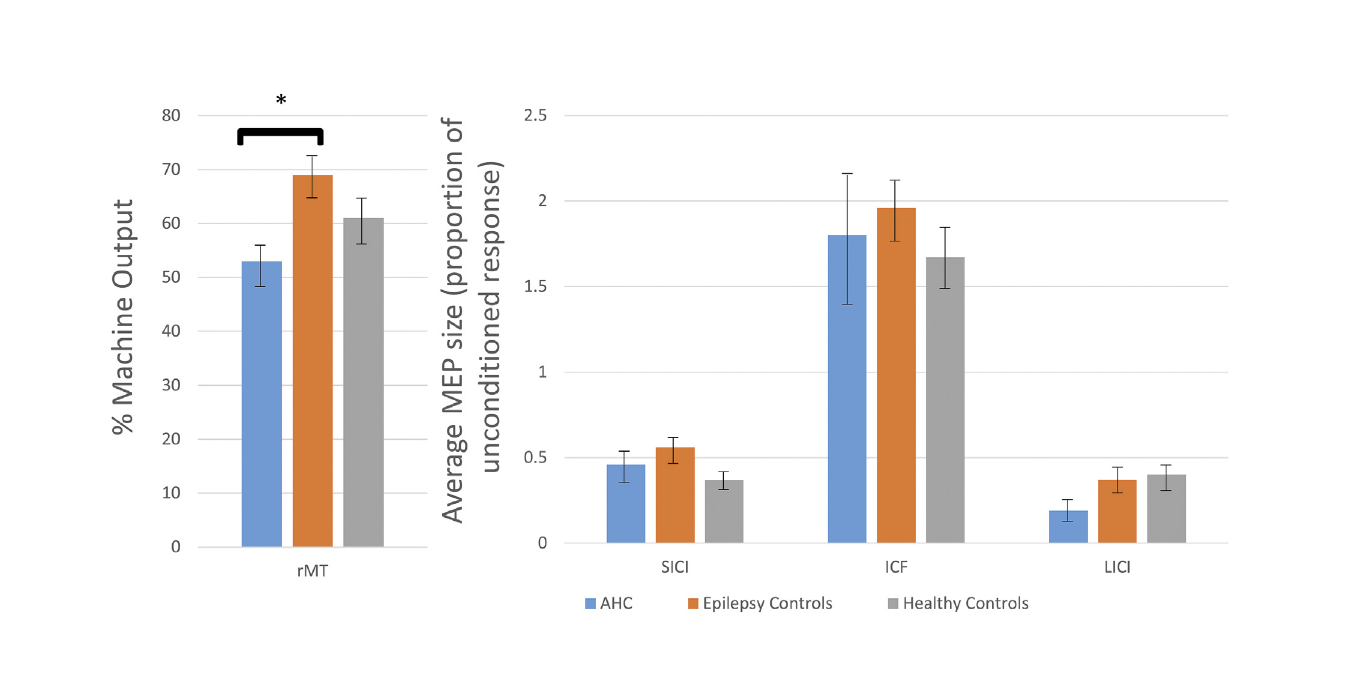
Fig 2. Mean results for resting motor threshold and paired pulse paradigms. Mean results for resting motor threshold (rMT), short interval intracortical inhibition (SICI), intracortical facilitation (ICF) and long interval intracortical inhibition (LICI) for people with alternating hemiplegia of childhood (AHC) and control subjects. There was a significant difference only in rMT (indicated by * , P = 0.002). Error bars show standard error.